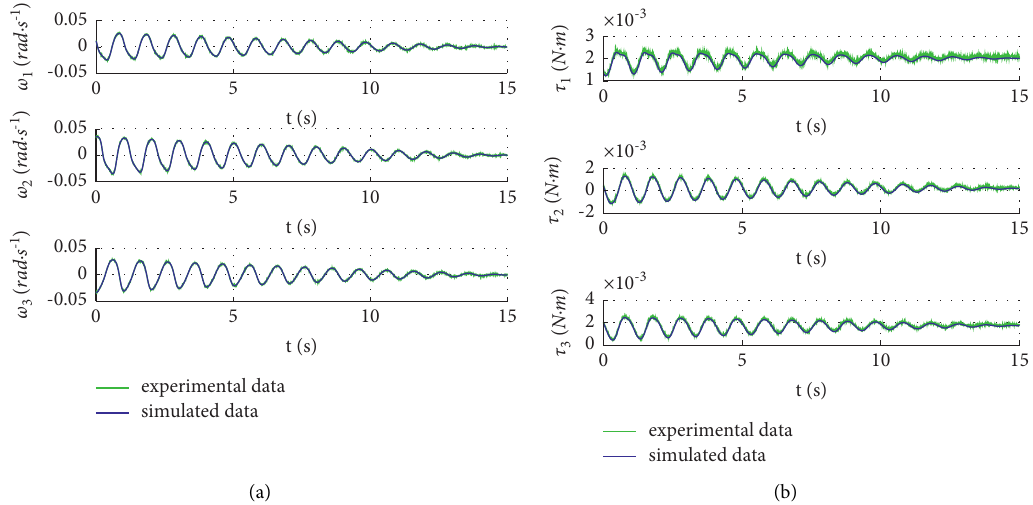
Figure 7: (a) Comparison of the simulation and experiment for the angular velocities of the active rod A and experiment for the driving moment of the active rod A i B i .